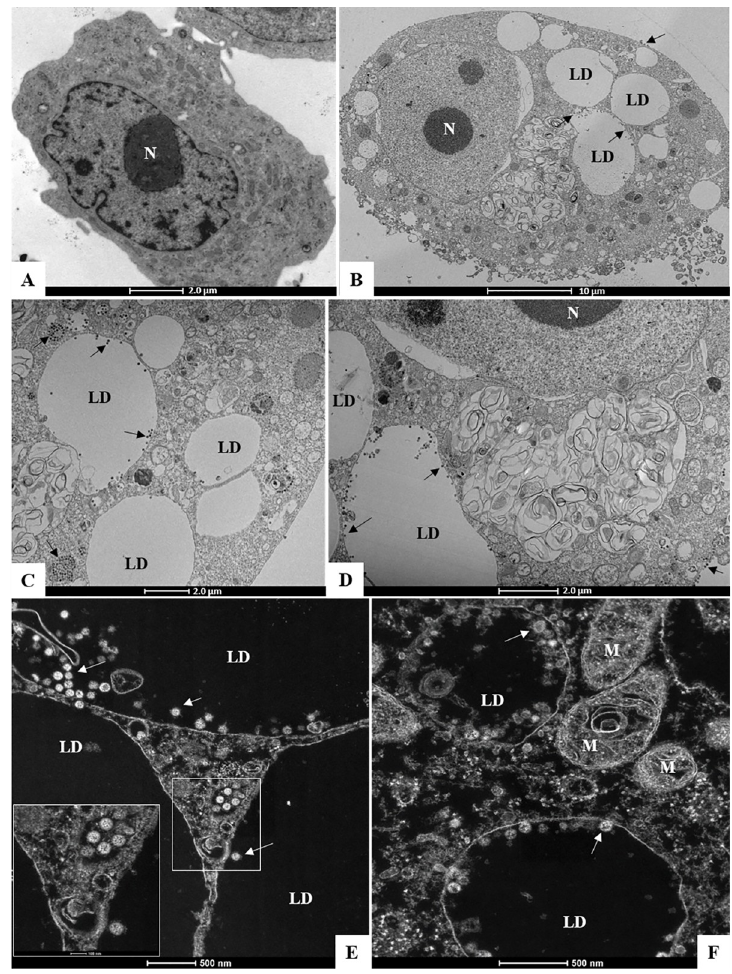
Fig 5. SARS-CoV-2 is associated with lipid droplet in Vero E6. Ultrastructural analyses by transmission electron microscopy of (A) uninfected Vero E6 Cell and (B-F) Vero E6 cells 48 hours post infection by SARS-CoV-2 (MOI 0.01). Arrows (virus particles), lipid droplet (LD), mitochondria (M), nucleus (N).